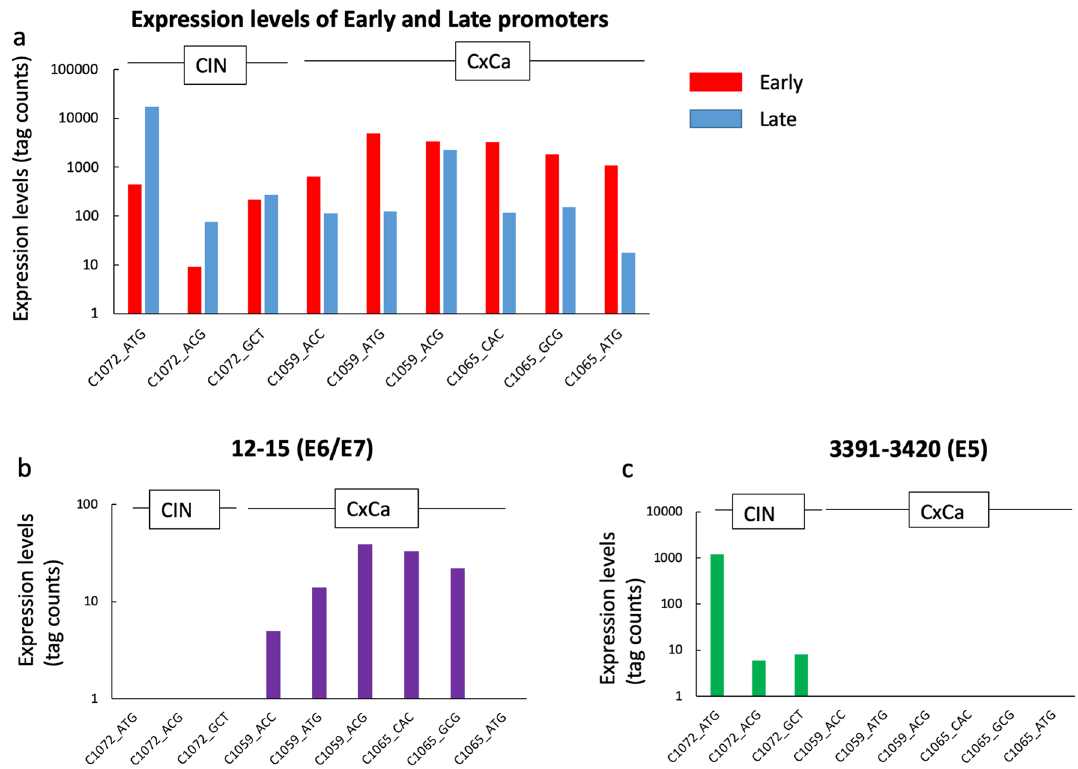
Figure 5. HPV-16–derived tag numbers of cervical samples by nAnTi-CAGE. ( a ) Expression levels of early and late promoters across the cervical samples. ( b ) The cluster located at nt12-15 for E6/E7 genes. ( c ) The cluster located at nt3391-3420 for E5 gene. HPV human papillomavirus; TSS transcription start site; CIN cervical intraepithelial neoplasia; CxCa cervical